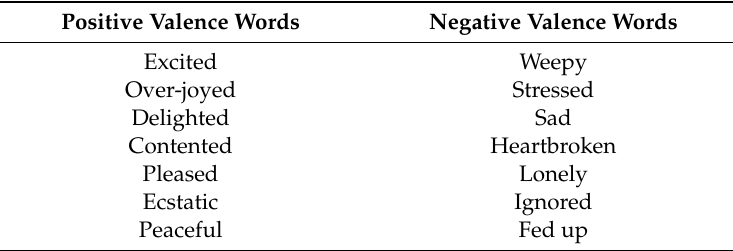
Table 1. Emotional words used during the Impulse